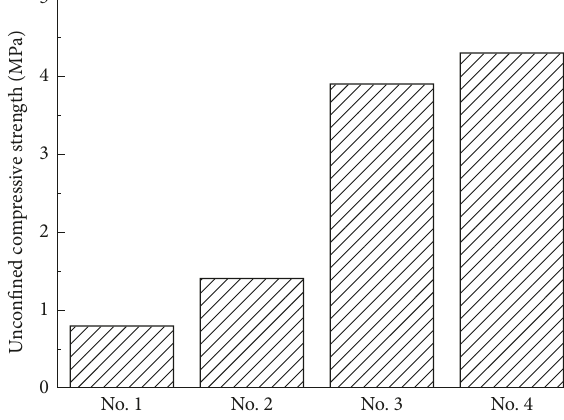
Figure 8: UCC strength of MICP-treated